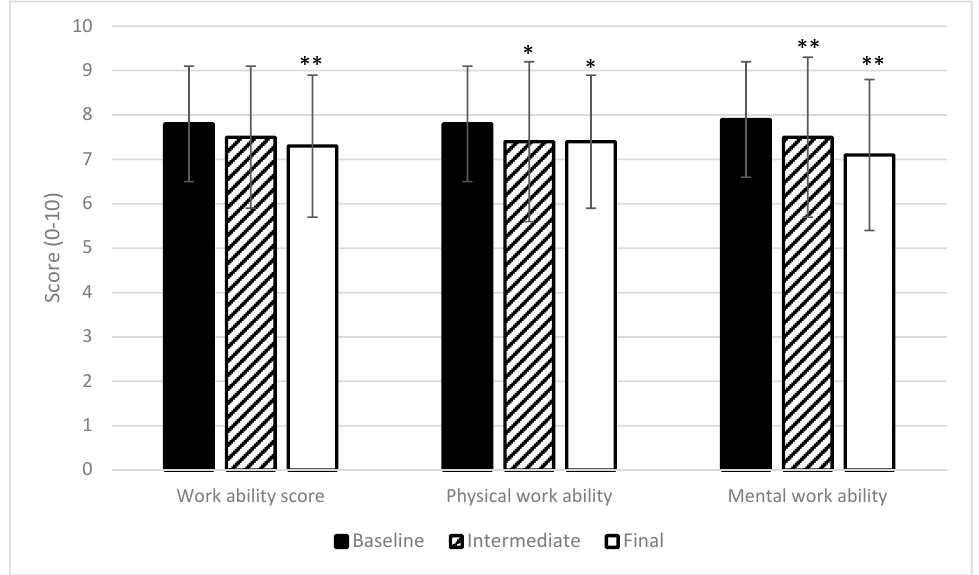
Figure 2. Trajectory of general, physical, and mental work ability during the peak season. Mean and SD are shown with error bars. A score of 0 stands for no work ability at all, and 10 corresponds to the best work ability ever experienced. Values with * or ** showed significant changes compared to baseline measurements: * p < 0.05, ** p < 0.01.